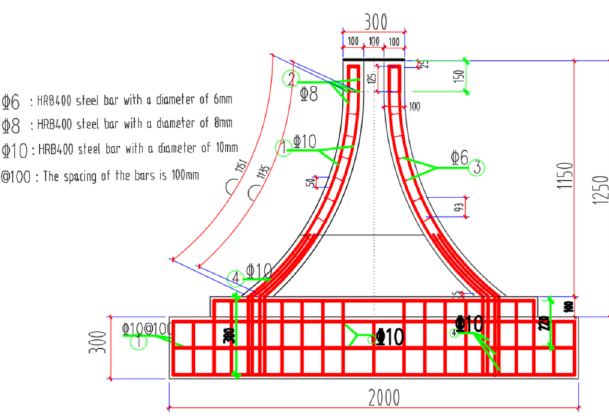
Figure 3. Schematic diagram of model size.